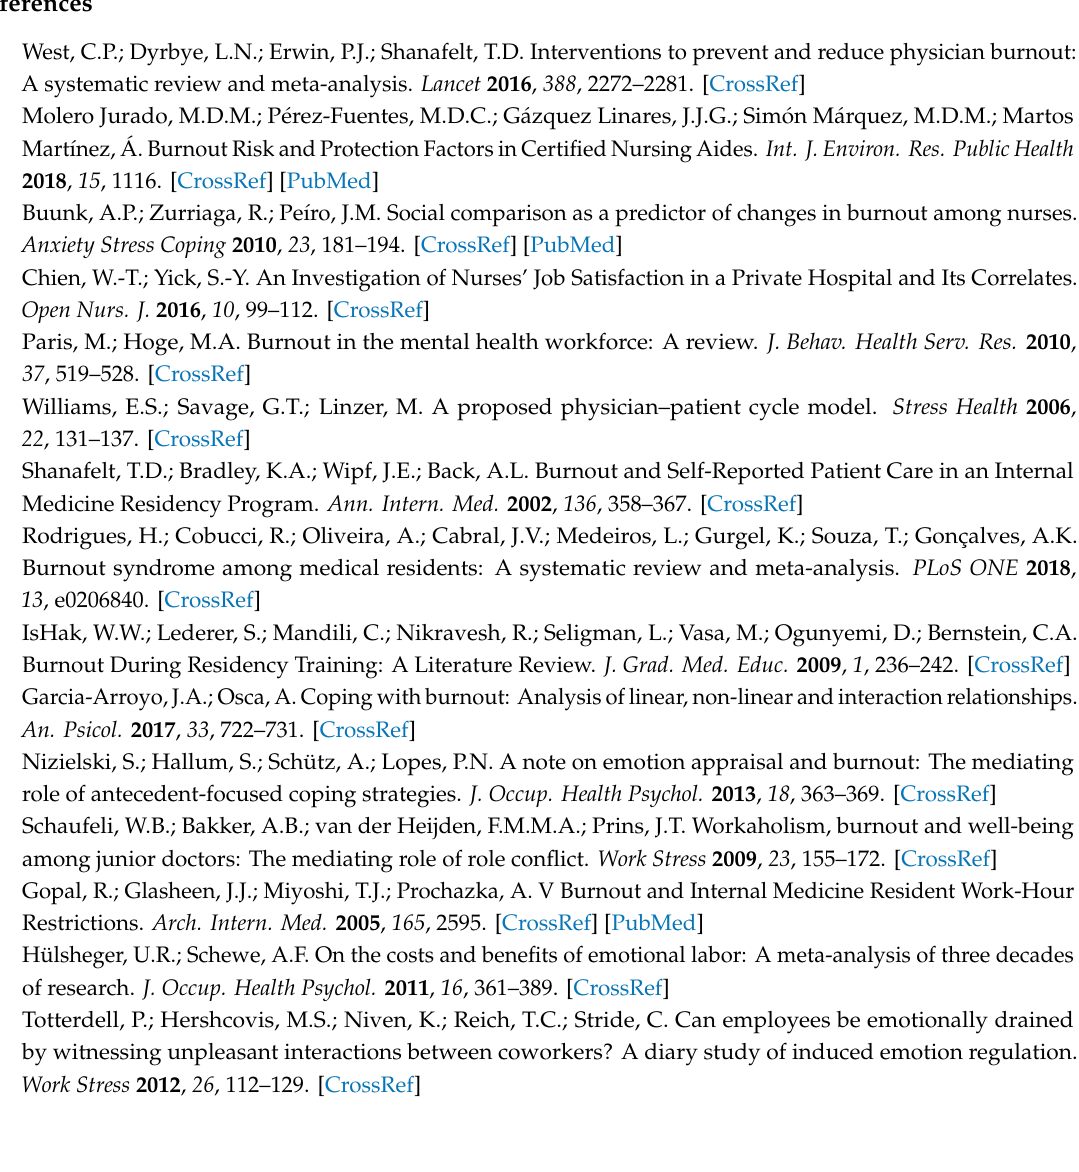
Table S1. Subjective Work Experience items, Table S2. Job Workload